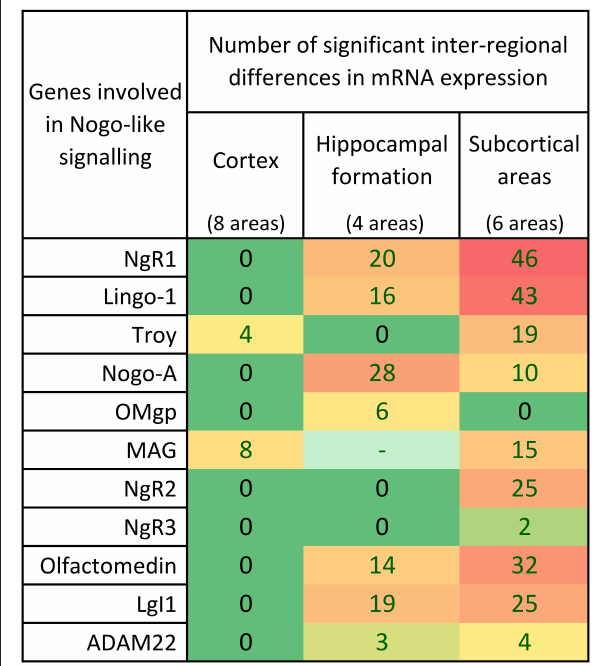
FIGURE 6 | Distribution of 175 significant changes ( p < 0.05) of mRNA expression over time for the 11 studied Nogo-related genes in the three main regions; cortex, hippocampal formation and subcortical areas. The changes are later described and visualized in charts in the paragraphs for each gene. In this table, significant change of mRNA expression between either neighboring time points (1 week – P0, 2 weeks – 1 week or 4 weeks – 2 weeks) or when comparing the mRNA expression in the adult 14 weeks old mice to that in P0, 1 or 2 weeks old mice, is coded using a green scale concerning increases, and decreases using a red scale. Notably, all genes except MAG decrease with time or lack a significant change in cortical areas, while hippocampal levels mostly increase with time. It is also the hippocampal formation that had significant changes in all but 2 of the investigated genes. Changes were detected with the help of a mixed model analysis, see statistics section.